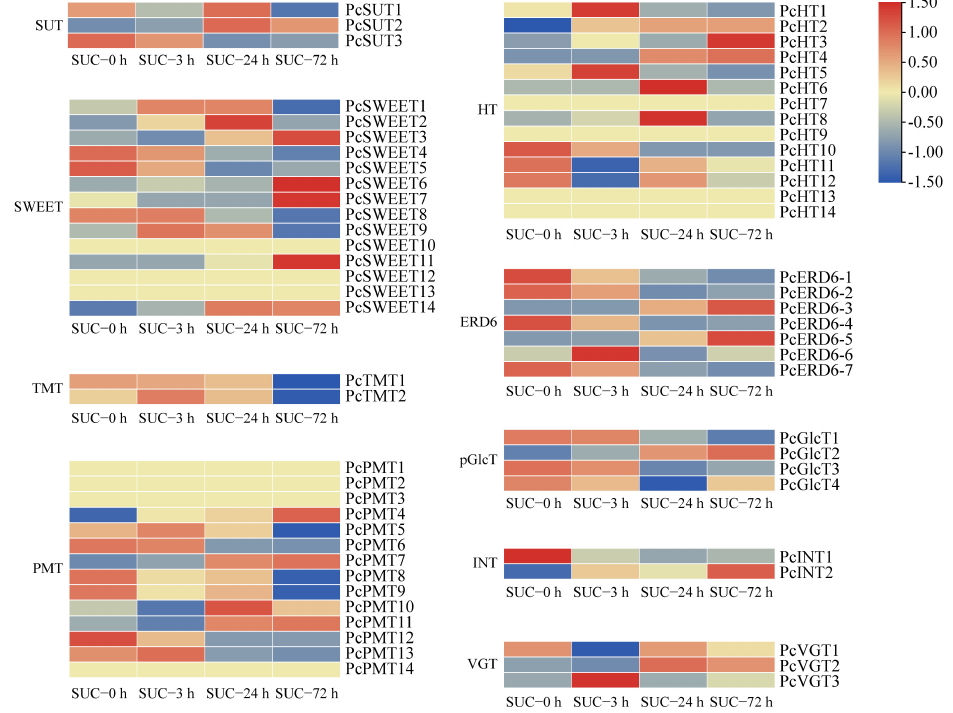
Figure 8. The expression profiles of the sugar transporter genes under sucrose treatment. Heatmap of the expression levels of sugar transporter genes using TBtools with the data normalized to a log scale and row scale. Red indicates a high expression level and green indicates a low expression